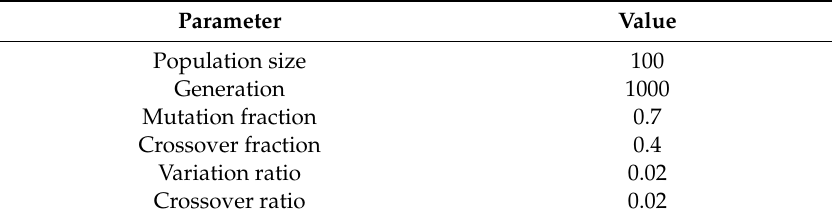
Table 5. Parameter of NSGA-II.